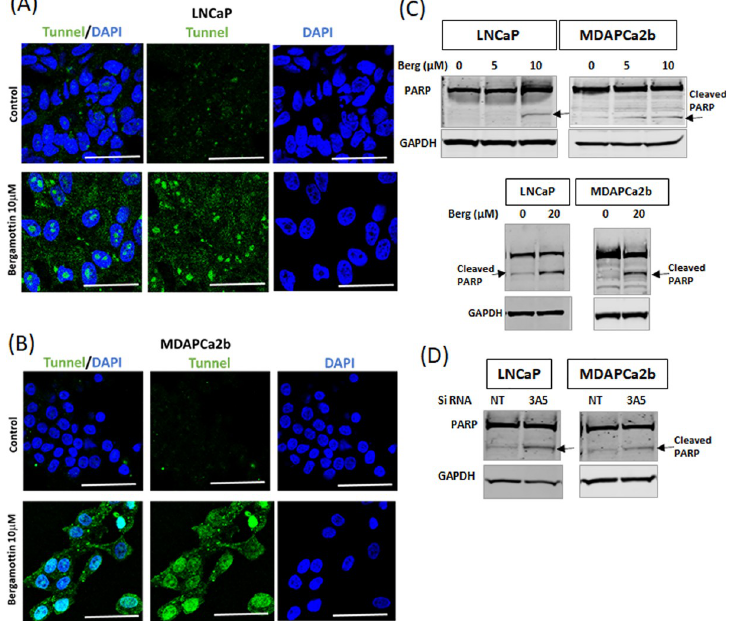
Fig 5. Bergamottin causes apoptosis in LNCaP and MDAPCa2b cells. (A & B) LNCaP and MDAPCa2b cells were treated with bergamottin (10 μ M) or DMSO (control) for 4 days. Cells were then fixed and stained for tunnel assay reagents as described in methods. Experiment was repeated three times and a representative experiment is shown. Size bar 50 μ m. DAPI was used to stain the nucleus. (C) Western blot analysis showing cleaved PARP after bergamottin treatment (5 and 10 μ M for 96 hrs. and 20 μ M for 48 hrs.), GAPDH was used as an internal control. (D) Western blot showing PARP cleavage after CYP3A5 siRNA and NT (non-target) siRNA treatment (96 hrs.).